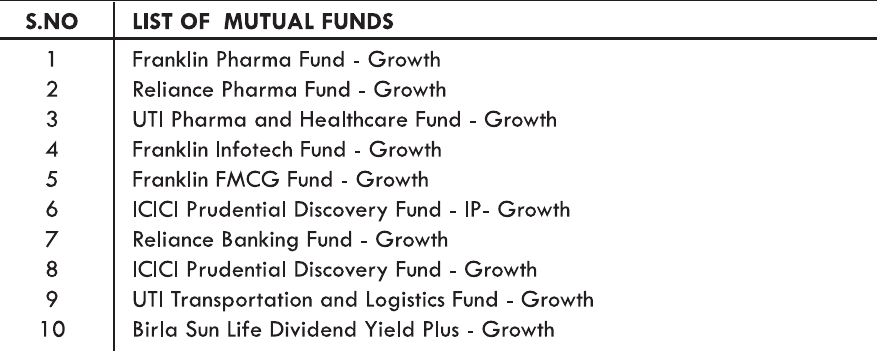
Table 1 : List of Sample Mutual Fund Schemes during the Year 2008 to 2010